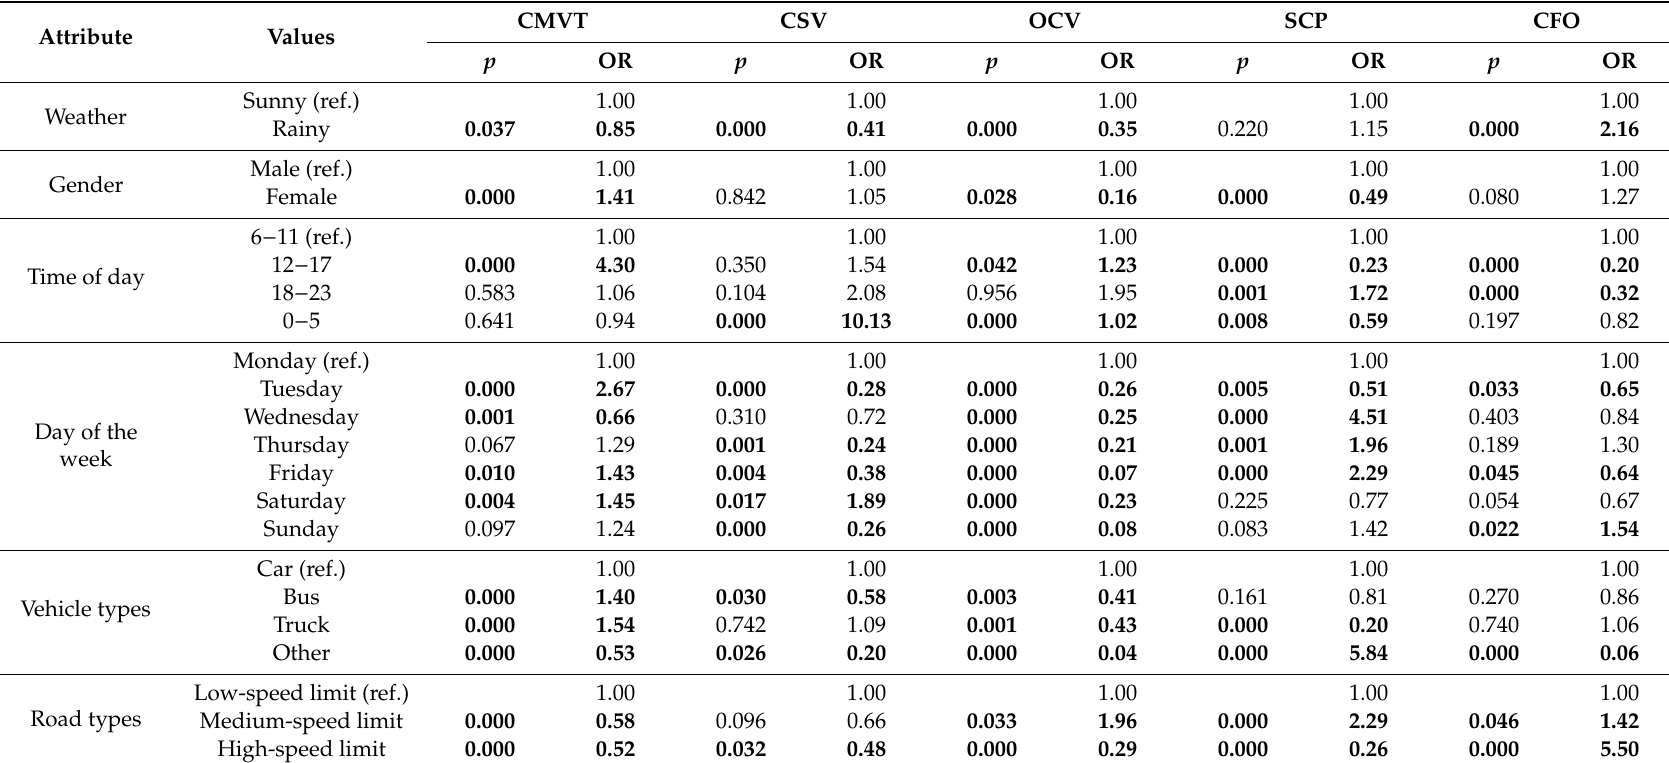
Table 3. Odds ratio results for younger